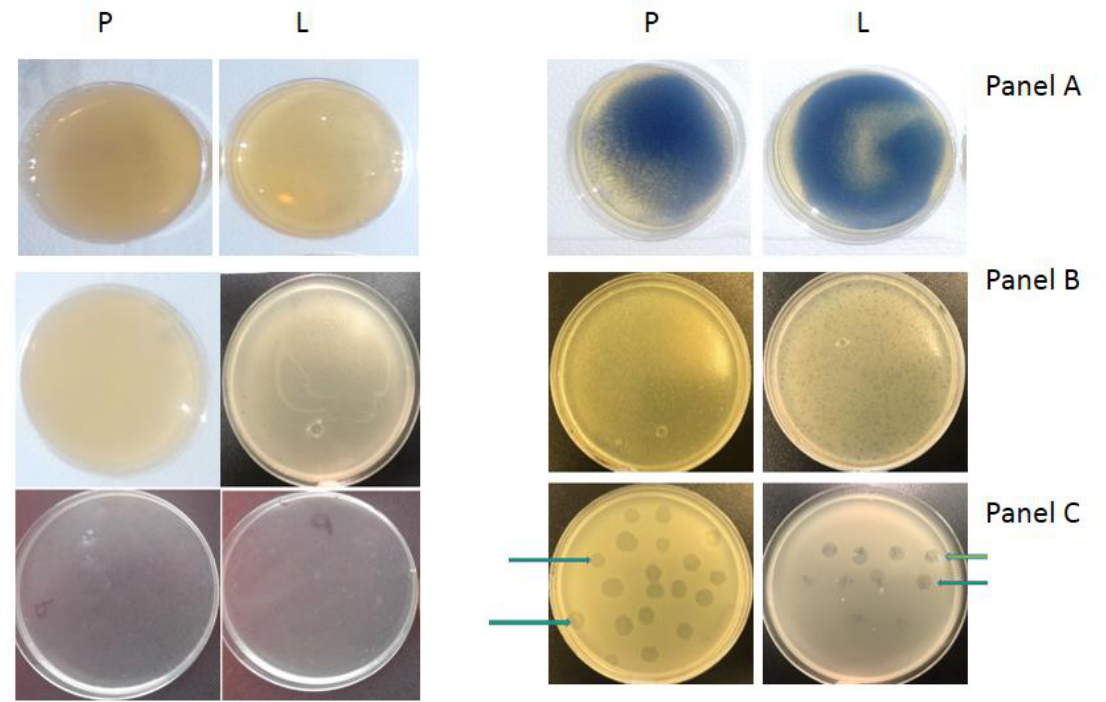
Figure 6. SARS-CoV-2 virus collected from the nasopharynx, after 24 h incubation. Viral inoculum were collected from healthy volunteers and individuals infected by SARS-CoV-2 of the nasopharynx, and were plated on both types of medium complete and selection medium ( A – C ).